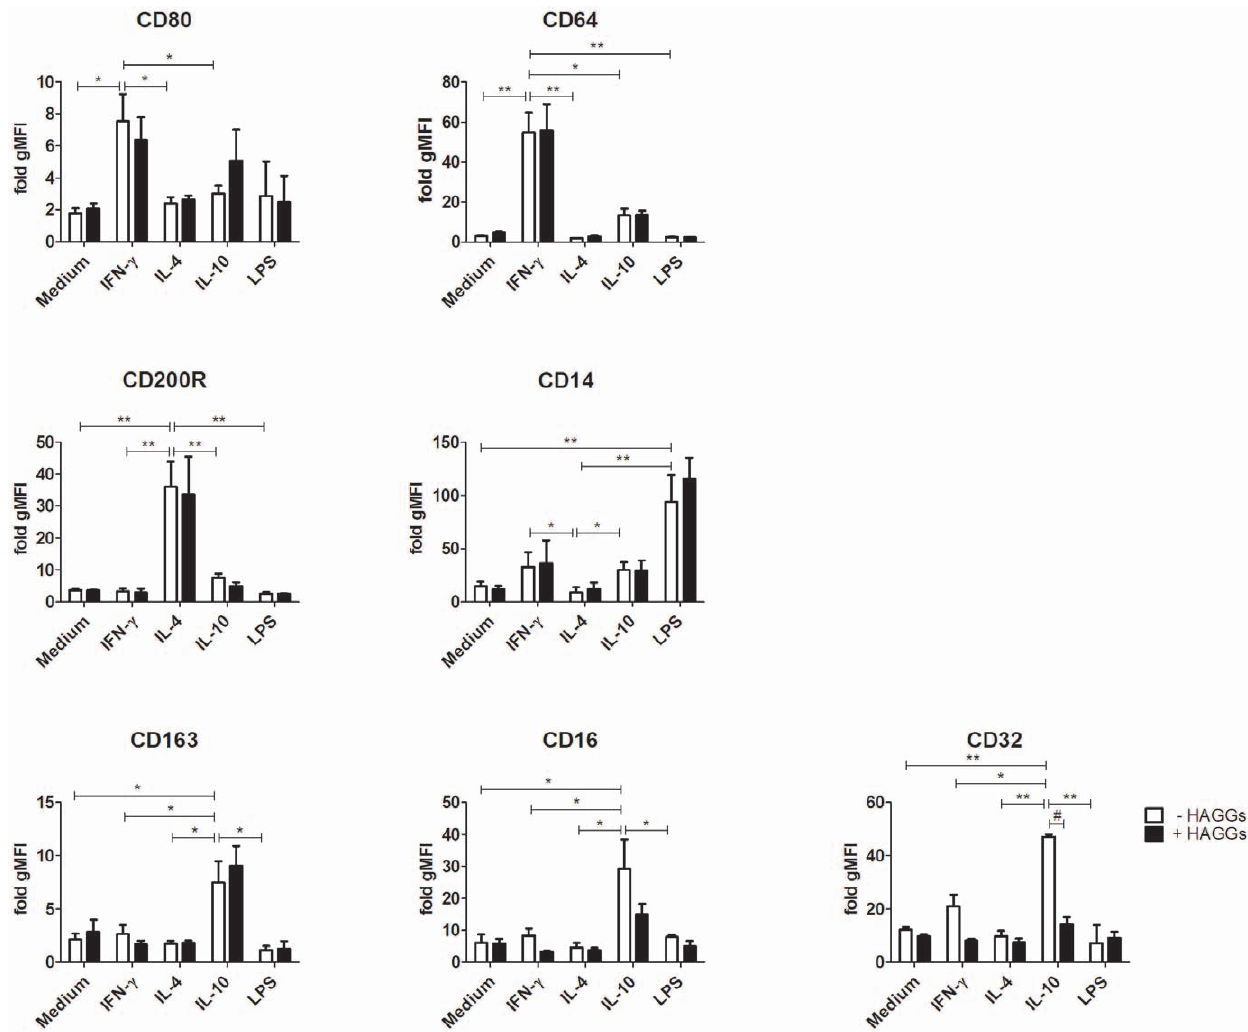
Figure 1. Expression of phenotypic markers on in vitro polarized human macrophages. Healthy peripheral blood monocytes were cultured for 4 days in medium or in medium supplemented with IFN- c , IL-4, IL-10, or LPS in the absence (white bars) or presence (black bars) of HAGGs. Expression of M W IFN- c markers CD80 and CD64, M W IL-4 markers CD200R and CD14, and M W IL-10 markers CD163, CD16 and CD32 was measured by flow cytometry. Bars represent the mean 6 SEM of 4 independent experiments. *p , 0.05, **p , 0.01, # p , 0.01.